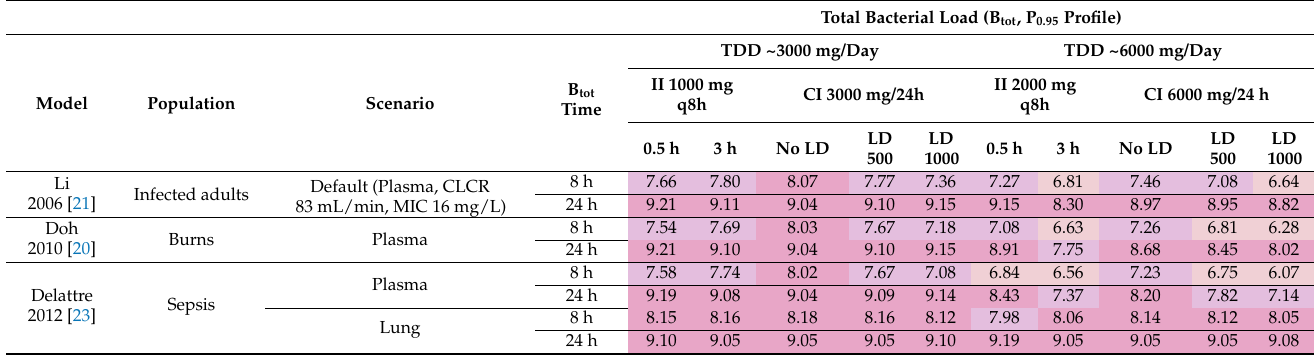
Table 1. Total bacterial load at 8 h and 24 h based on PKPD profiles covering 95% of patients. Total Bacterial Load (B tot , P 0.95